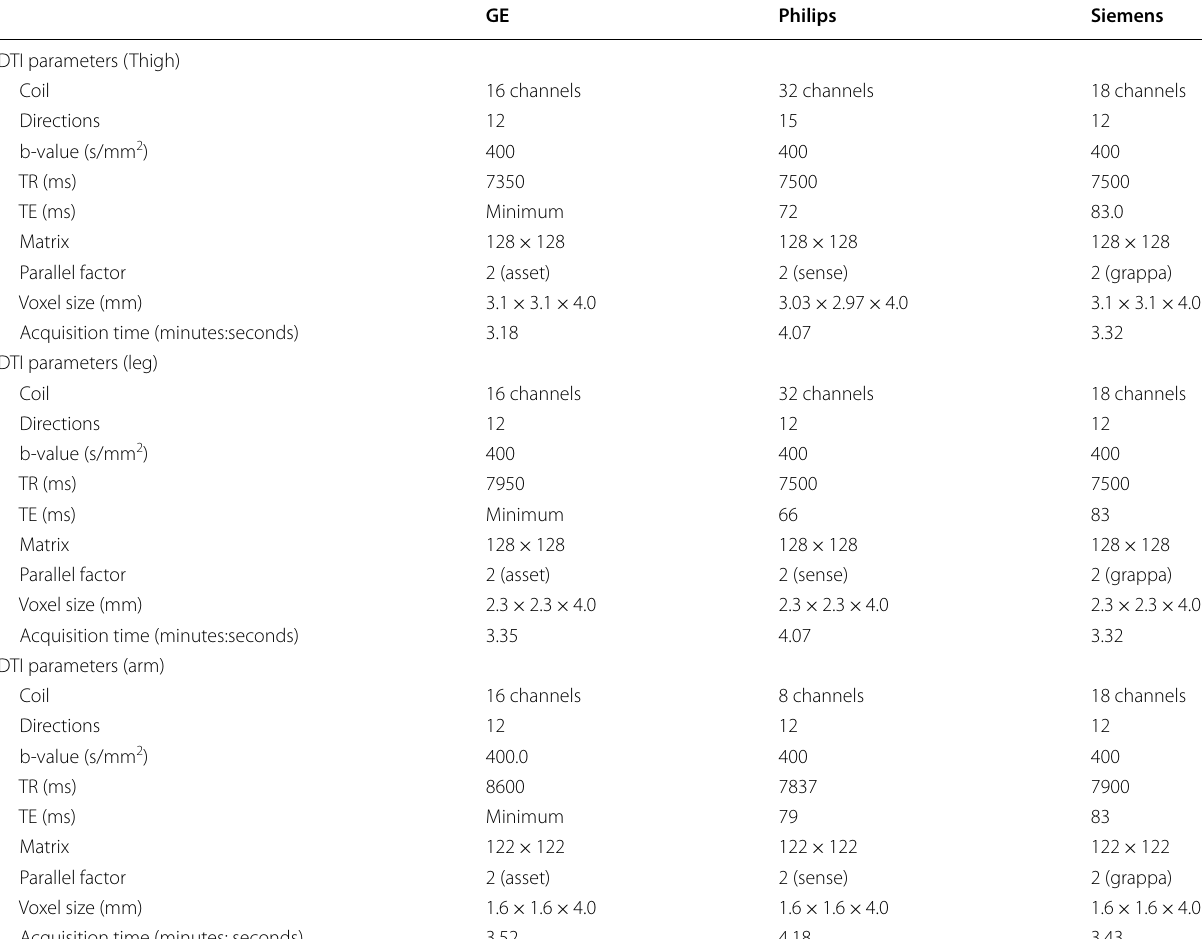
Table 1 DTI acquisition parameters